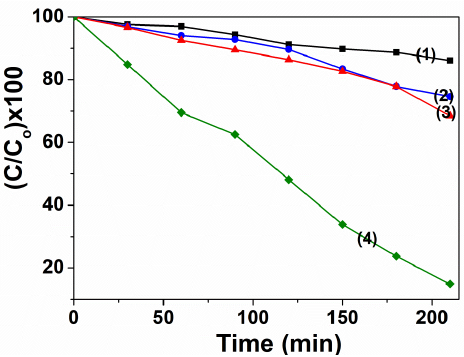
Figure 7. The photocatalytic degradation of RhB in different conditions: curve (1), 10.0 mg/L RhB + 0.04 M H 2 O 2 + light; curve (2), 10.0 mg/L RhB + 0.1 g ZnFe 2 O 4 + light; curve (3), 10.0 mg/L RhB + 0.1 g ZnFe 2 O 4 + 0.04 M H 2 O 2 + dark; curve (4), 10.0 mg/L RhB + 0.1 g ZnFe 2 O 4 + 0.04 M H 2 O 2 + light.